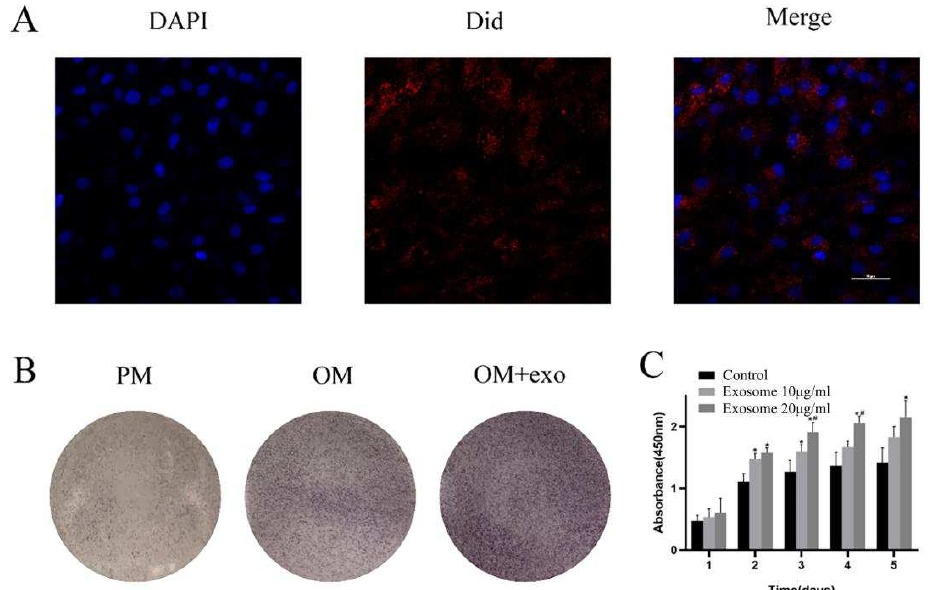
Figure 2. Effects of exosomes on proliferation and osteogenic differentiation of BMSCs ( A ) Ingestion of exosomes by BMSCs ( B ) ALP staining after 14 days of osteogenic induction ( C ) CCK-8 assay results; Asterisk (*), p < 0.05 compared to the control group; pound sign (#), p < 0.05 compared to the exosome 10 μg/mL group.